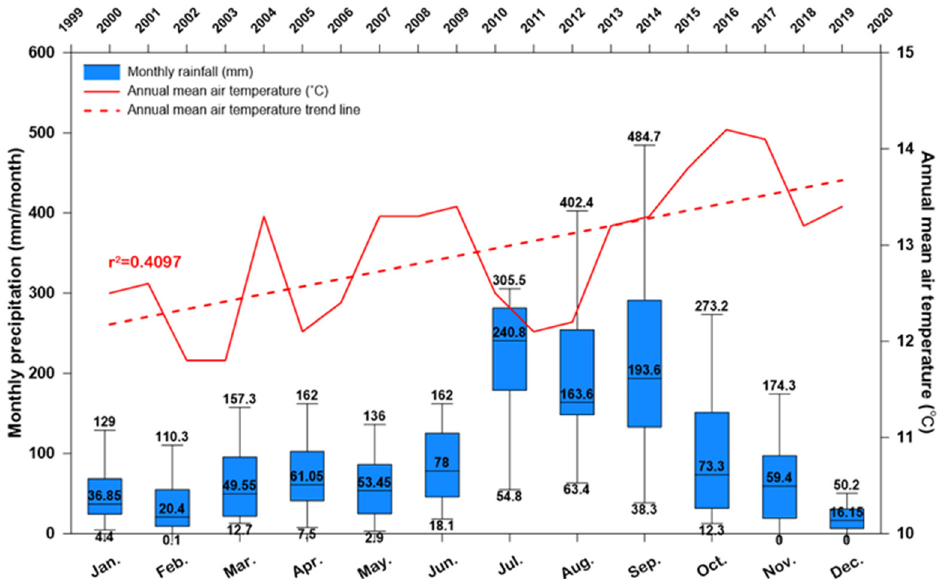
Figure 2. Annual average air temperatures and boxplots of monthly precipitation for 20 years (2000–2019) in Samcheok.